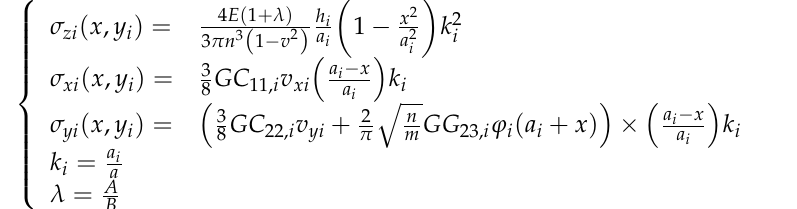
Figure 4. Critical rail sections and interpolation simulation of turnout: the critical rail sections in ( a ) the switch panel; ( b ) the crossing panel; ( c ) the stock rail and switch rail model.